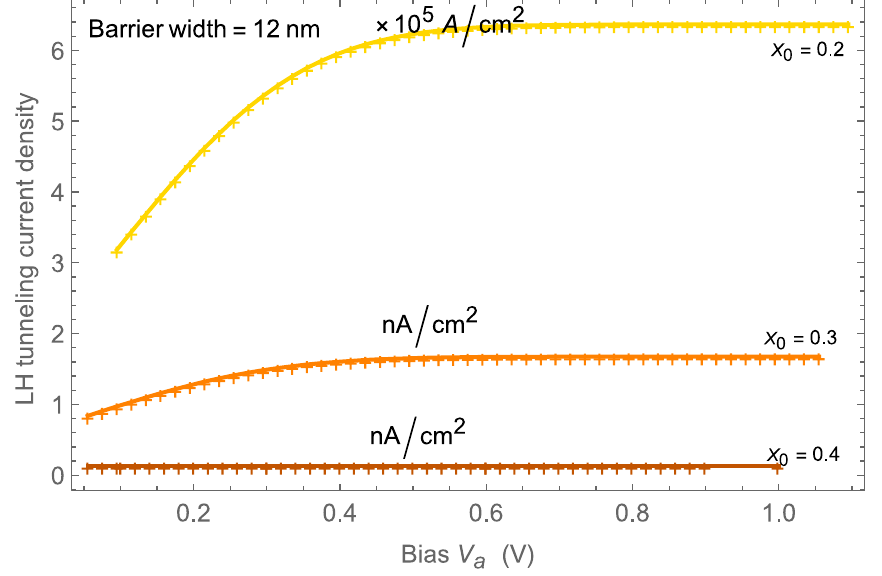
Figure 17. Current density-voltage characteristics of the LH tunneling at width barrier 12 nm.